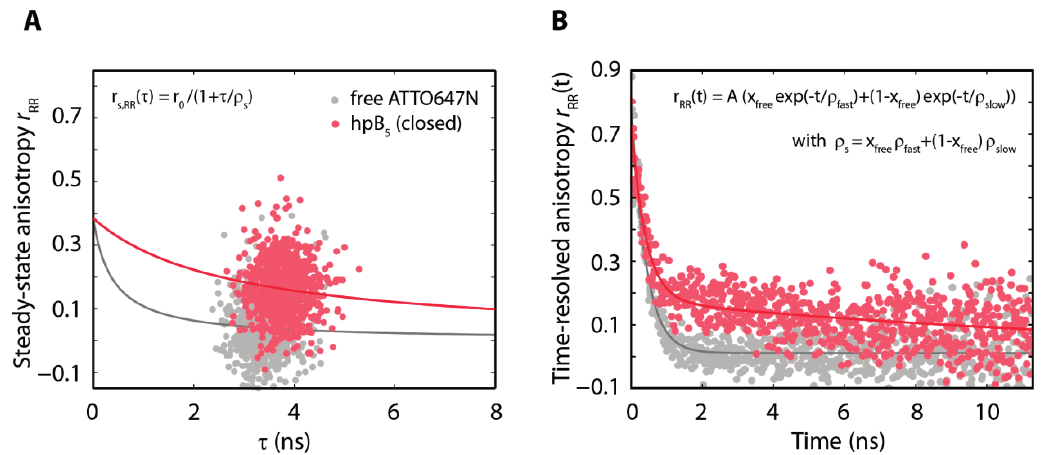
Figure 4. Global fitting of the steady state ( A ) and time-resolved anisotropy ( B ) for hpB in the closed conformation (red) reveals two rotational components. The fast decay originates from the freely rotating acceptor dye and the slow decay from the sticking of the acceptor dye to the hairpin. The freely rotating acceptor molecule (gray) shows a steady state rotational correlation time corresponding to the fast component in the hairpin and only a single exponential decay in the time-resolved anisotropy.